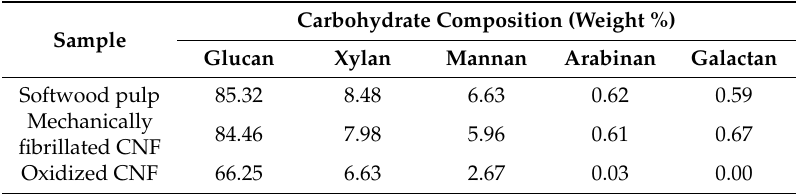
Table A1. Carbohydrate composition in the different